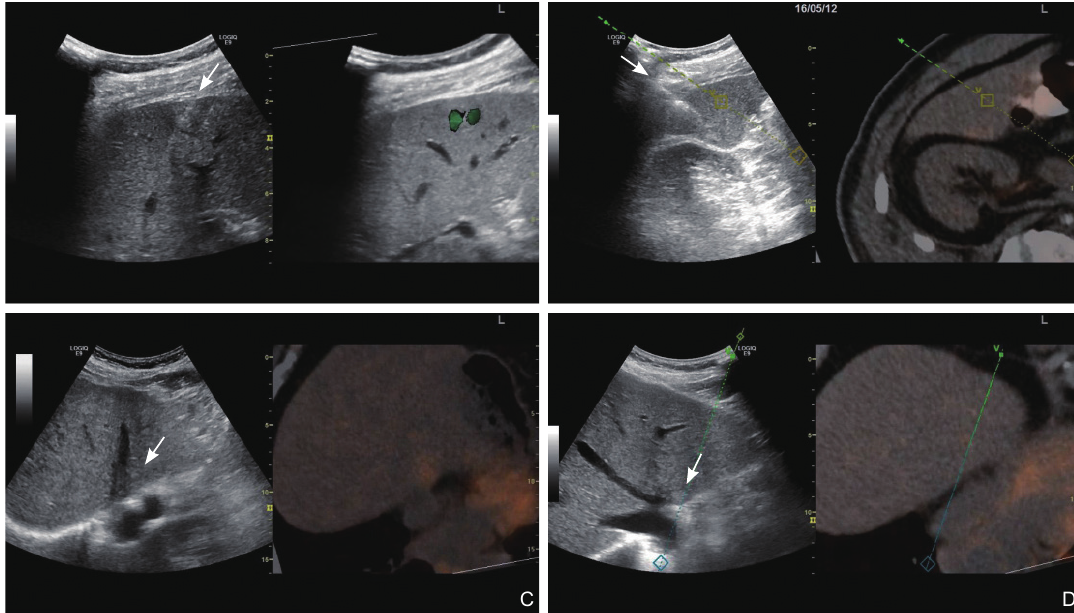
Figure 2 Fused images of positron emission tomography/computed tomography (PET/CT, right) and ultrasound. Liver metastasis lesions were observed on PET/CT images (right) and ultrasound images (left). (A) The needle direction of the lesion in the right anterior lobe, near the liver surface, in microwave ablation (arrow). (B) The needle direction of the lesion in the right posterior lobe in microwave ablation (arrow). (C and D) The needle direction of the lesion in the left outer lobe are near the second hepatic gate in microwave ablation